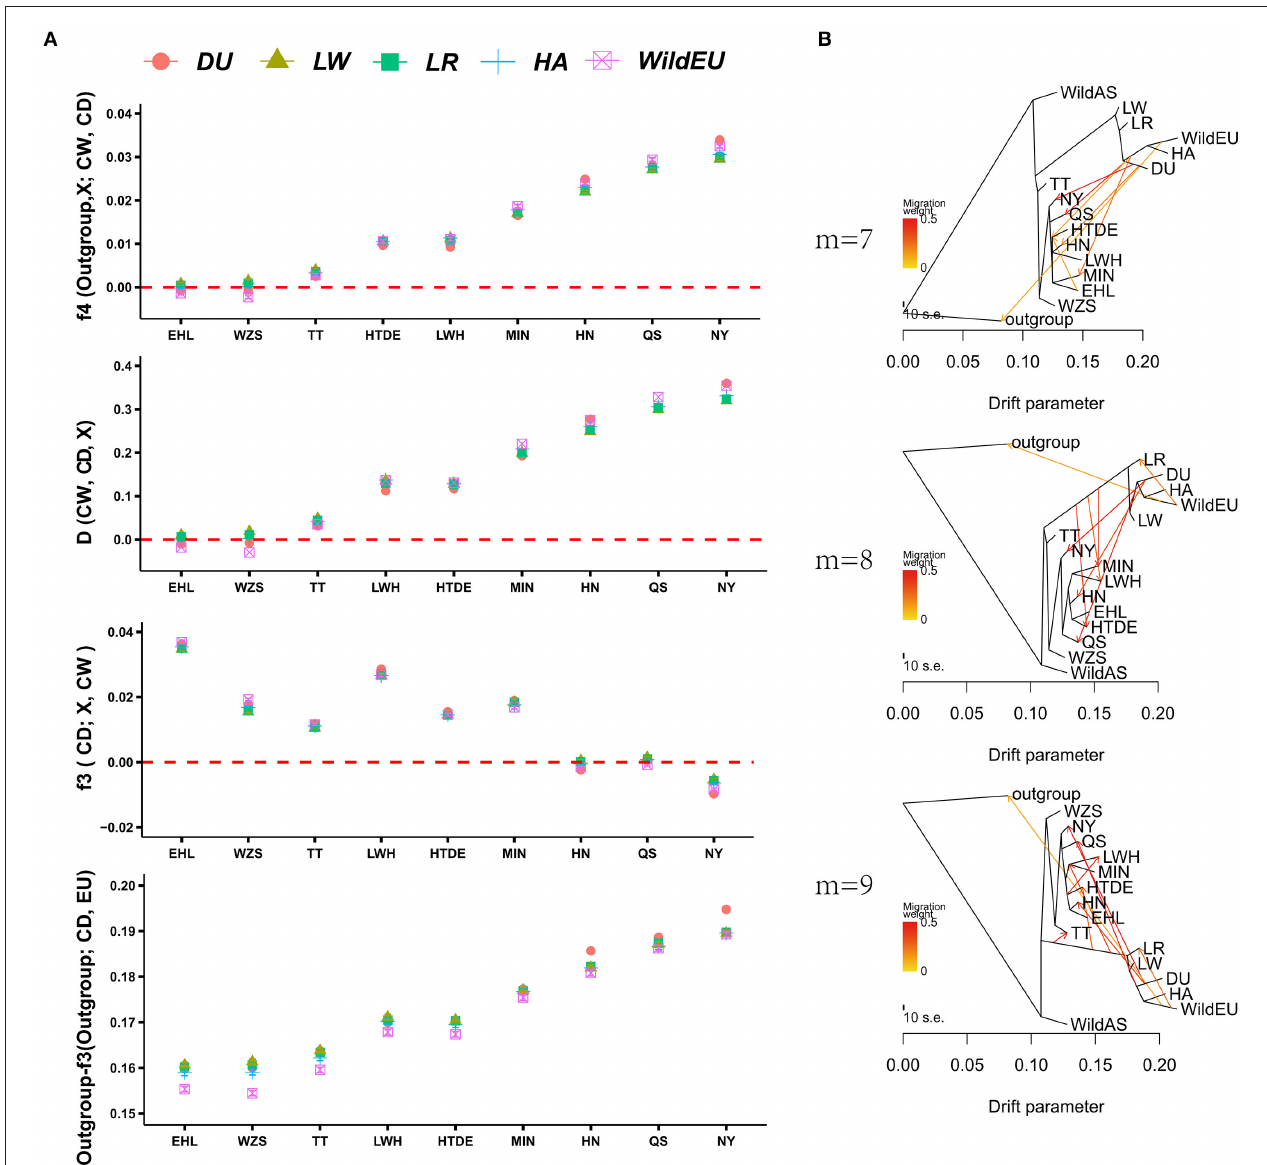
FIGURE 2 | Admixture of Chinese indigenous pigs and European pigs. (A) Evidence from f4 statistics, D-statistics , f3 statistics, and outgroup-f3 statistics showing admixture of Chinese and European pigs. (B) TreeMix analysis revealing gene flow from European to Chinese pigs.